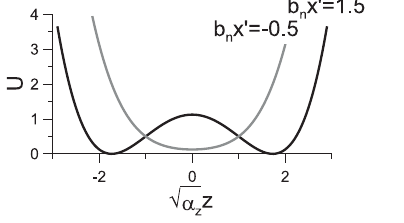
(b n x 0 − 1 α z z 2 ) 2 2 2